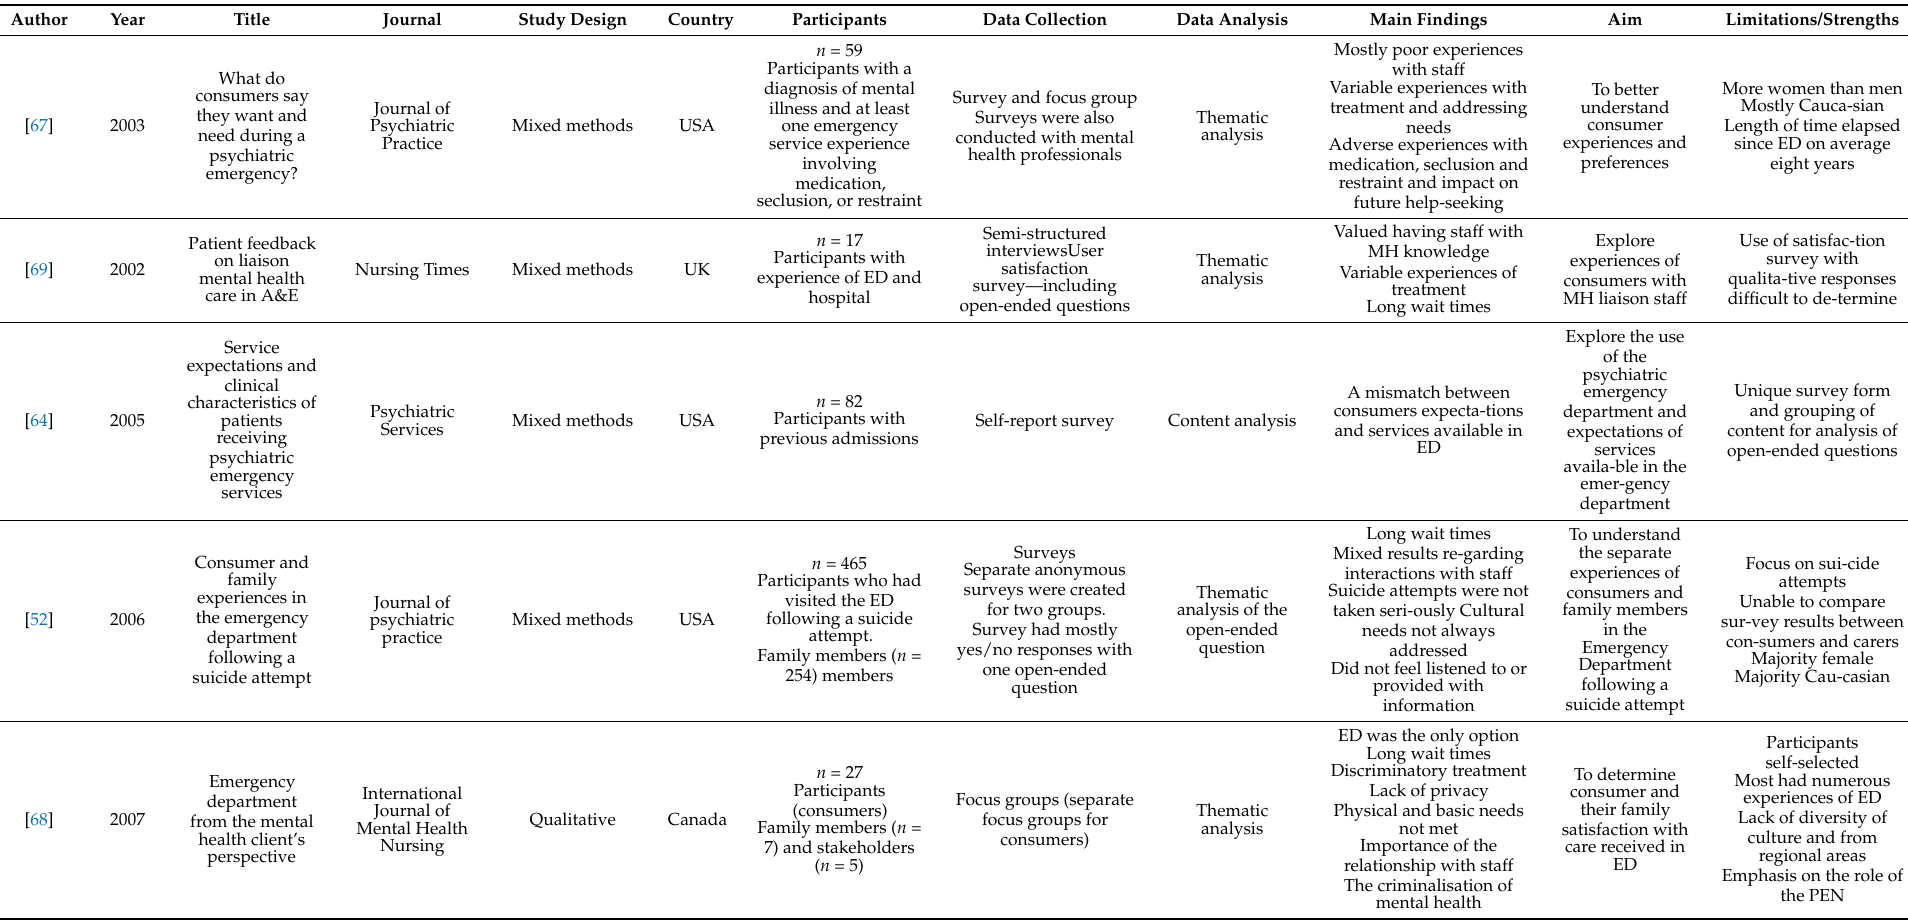
Table A1. The data extraction table of included